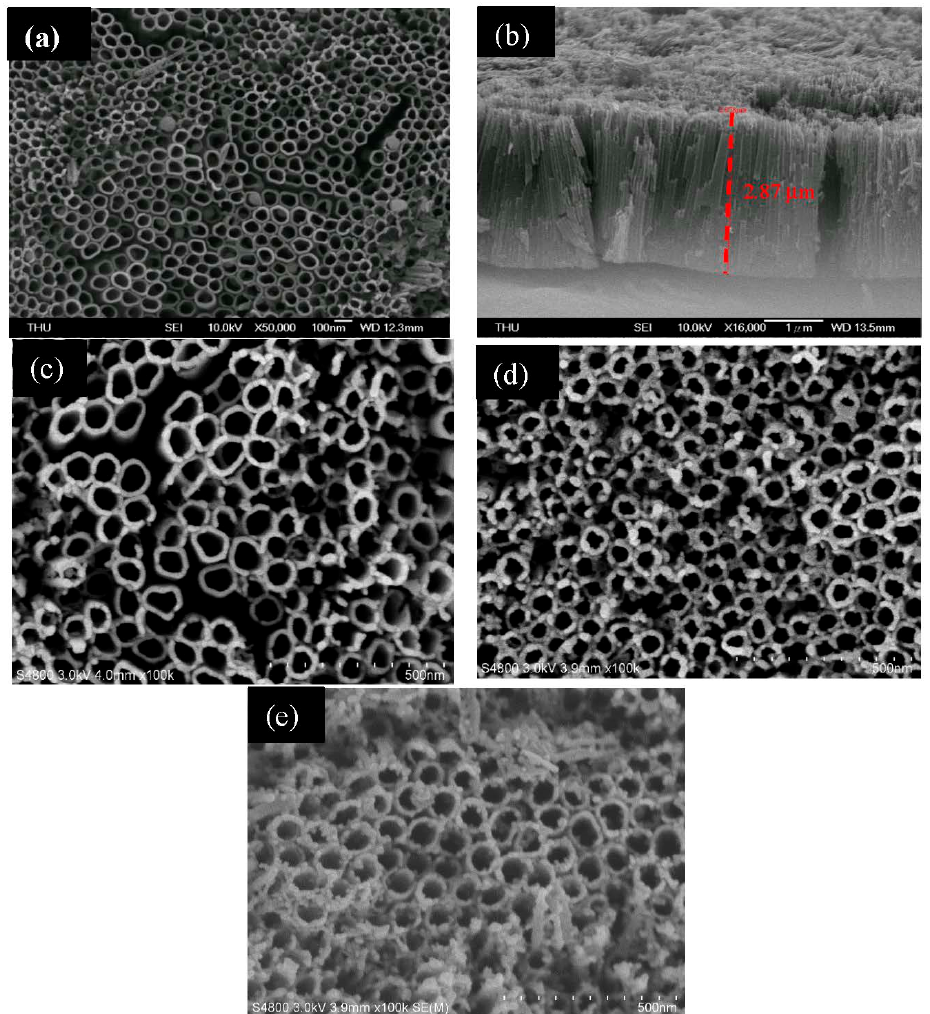
Figure 1. SEM images of ( a ) titanium dioxide nanotube arrays (TNAs), ( b ) TNAs (cross section), ( c ) palladium modified TNAs (Pd/TNAs), ( d ) Pd/TNAs-C and ( e ) Pd/TNAs-G.